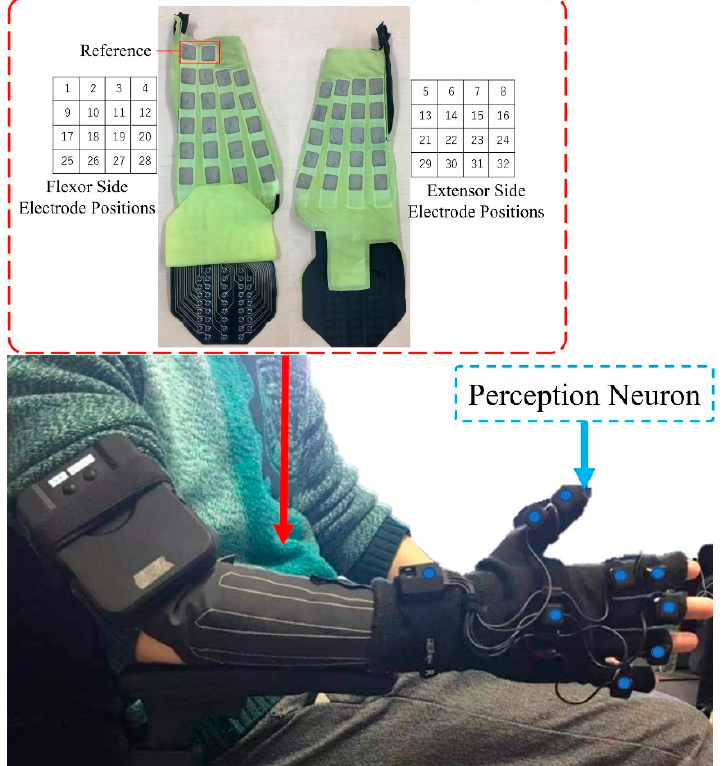
Figure 2. Thirty-two-channel multiarray electrode forearm gloves and the Perception Neuron Motion Capture System. The blue point on each location represents the sensor of the perception neuron.